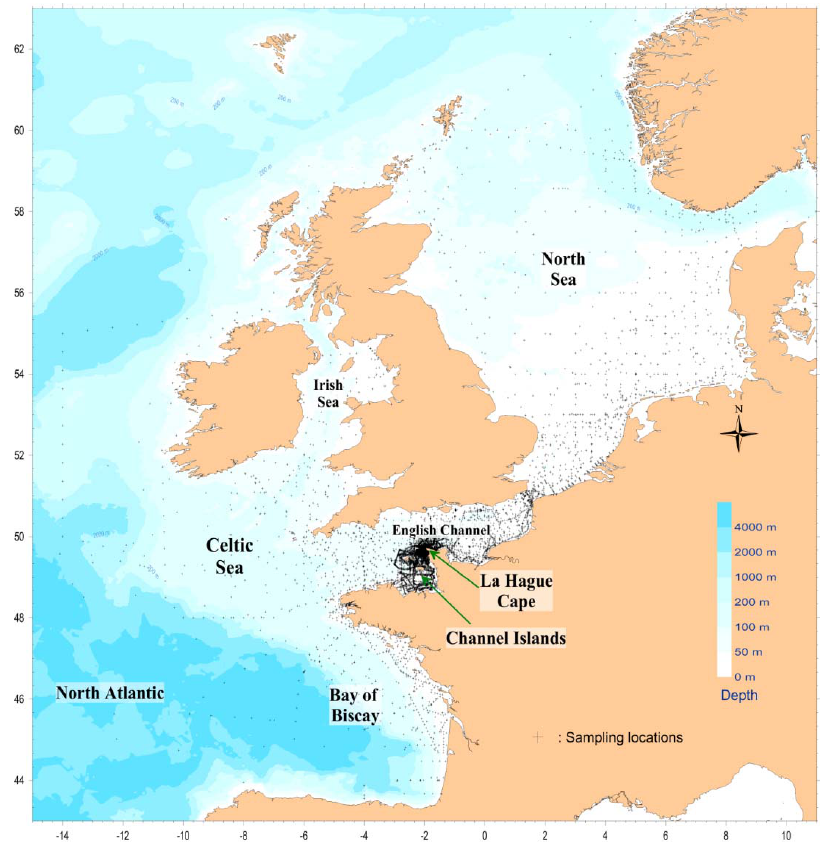
Figure 3. Location of radionuclide measurements samples obtained between 1982 and 2016.